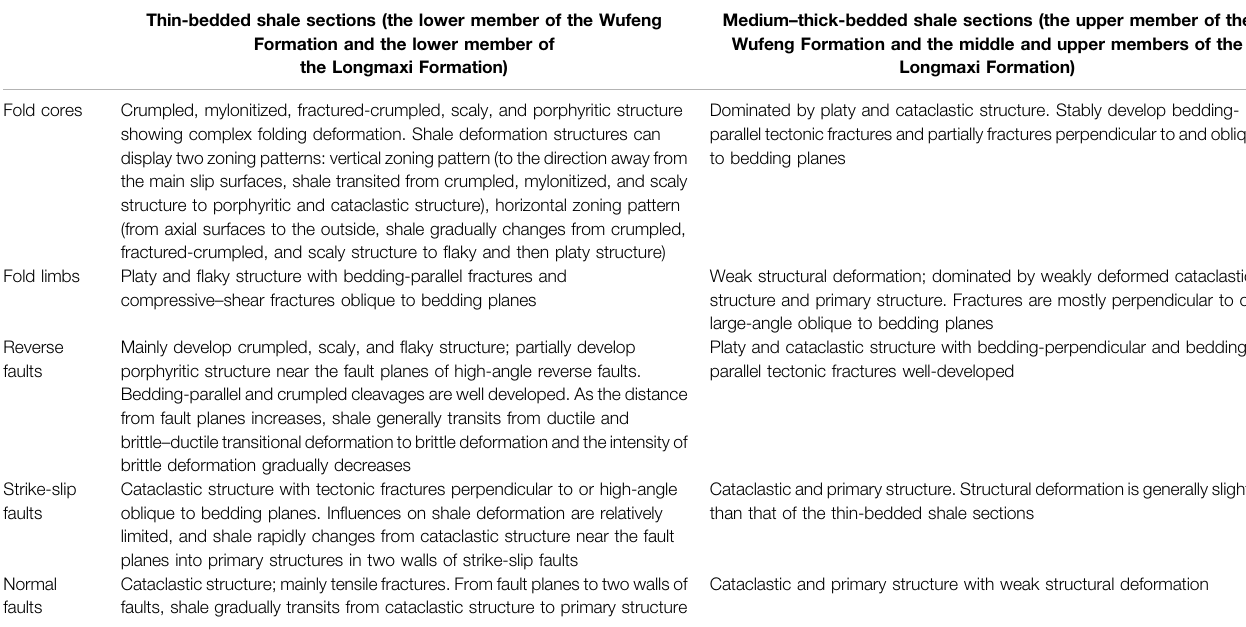
TABLE 1 | Shale deformation characteristics in different structural